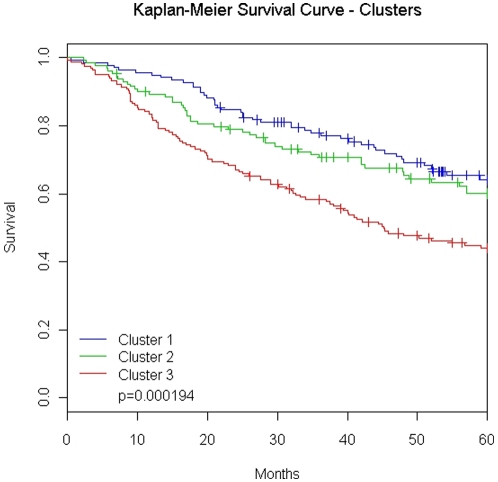
Clusters show survival differences.Kaplan-Meier survival curves for 432 lung adenocarcinomas (AD) showing a significant difference between clusters (log-rank test: p = 0.000194). Abbreviations: Cluster 1, left most cluster in Figure 2; Cluster 2, middle cluster is Figure 2; Cluster 3, right most cluster in Figure 2.